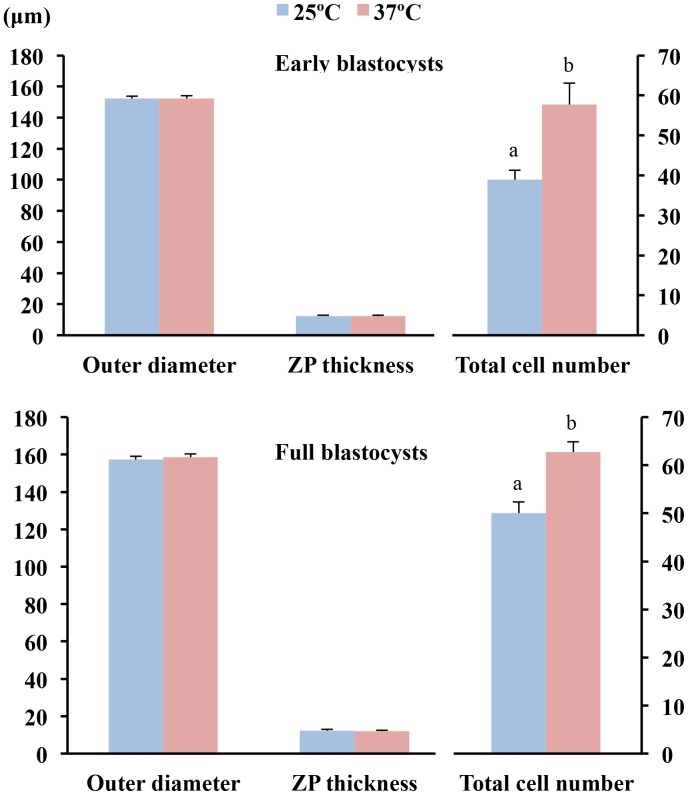
Cell numbers of blastocysts with similar sizes derived from morulae cultured for 24 h at 25°C or 37°C.The total cell count (means ± S.E.M.) was performed in selected embryos in the early blastocyst (n = 30) and the full blastocyst (n = 24) stages. Different letters represent differences (P<0.001) in the total cell number between groups.